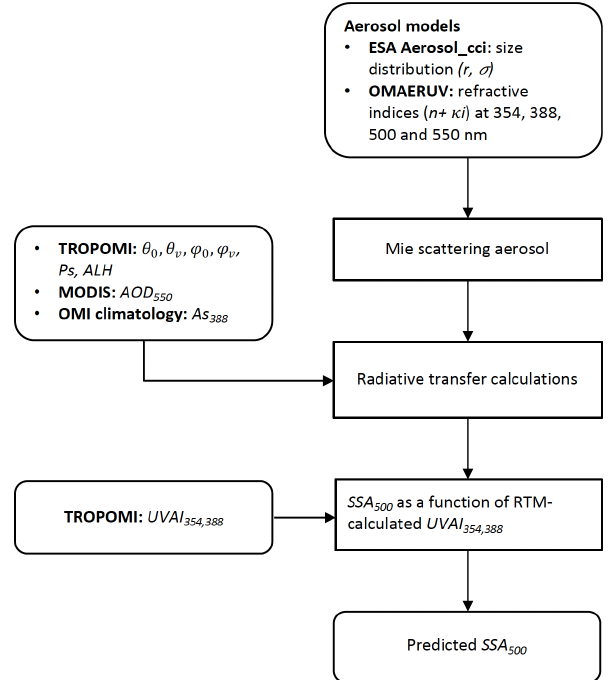
Figure 1. Procedure of the radiative transfer simulation of UVAI. The aerosol models are from the ESA Aerosol_cci project (Holzer- Popp et al., 2013) and the OMAERUV algorithm (Torres et al., 2007, 2013). The satellite inputs are the TROPOMI measurement geometry and ALH, the MODIS AOD and the OMI surface clima- tology. The aerosol profile is parameterized as a one-layered box- shaped profile, with the central layer height set to the TROPOMI ALH and an assumed constant pressure thickness of